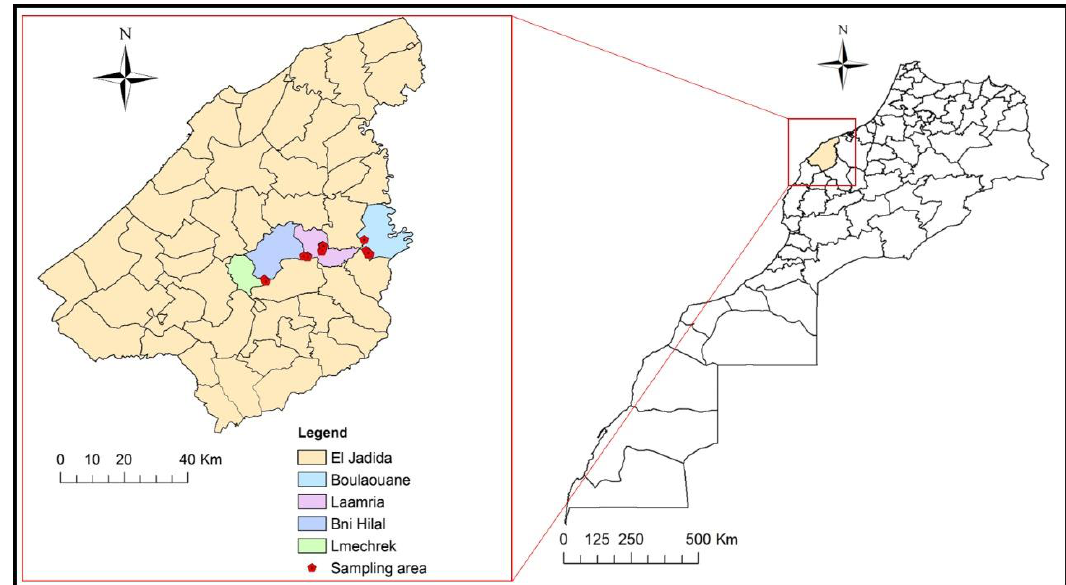
Figure 6. Map showing locations of the Doukkala-Abda region in Morocco ( right square ) and enlarged views of Boulaouane, Laamria, Bni Hilal and Lmechrek ( left square ). The map was created by ArcGIS software version 10.9 (Redlands, CA, USA) and indicates the names of different districts where samples were collected.